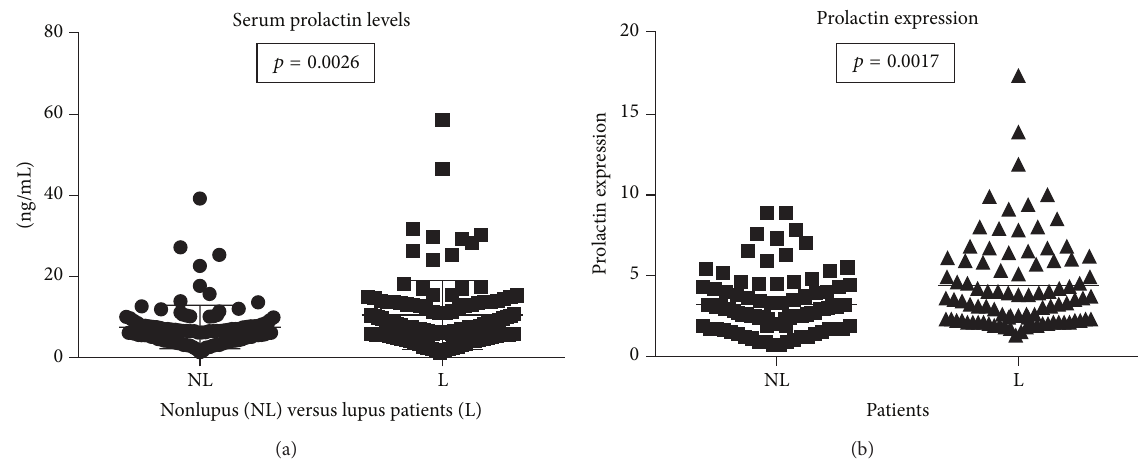
Figure 2: Prolactin expression and serum levels. Patients with lupus have significantly higher serum levels of prolactin ( 𝑝 = 0.0026 ) and expression at the mRNA level in PBMCs ( 𝑝 = 0.0017 ), although individual differences are shown among the patients.